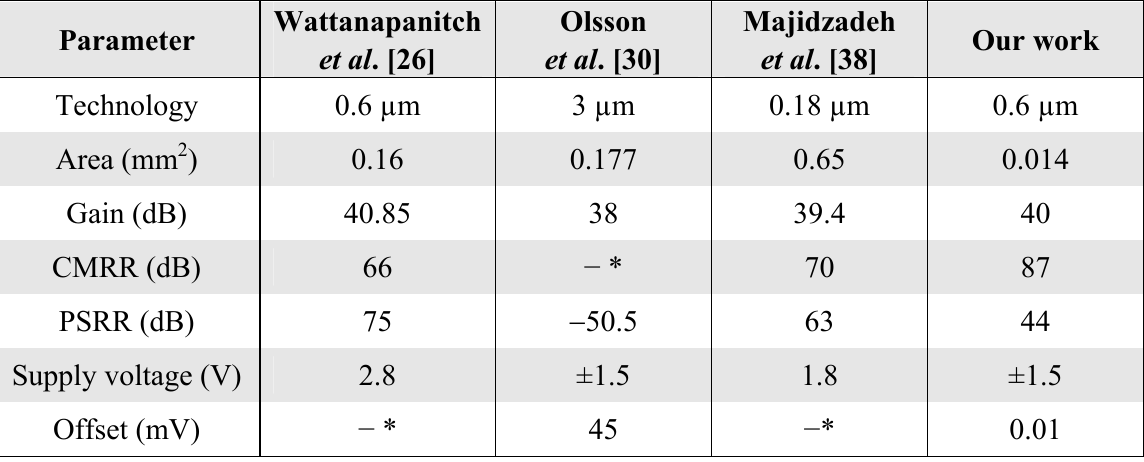
Table 2. Electrical characteristics of some readout circuits for recording the neuronal